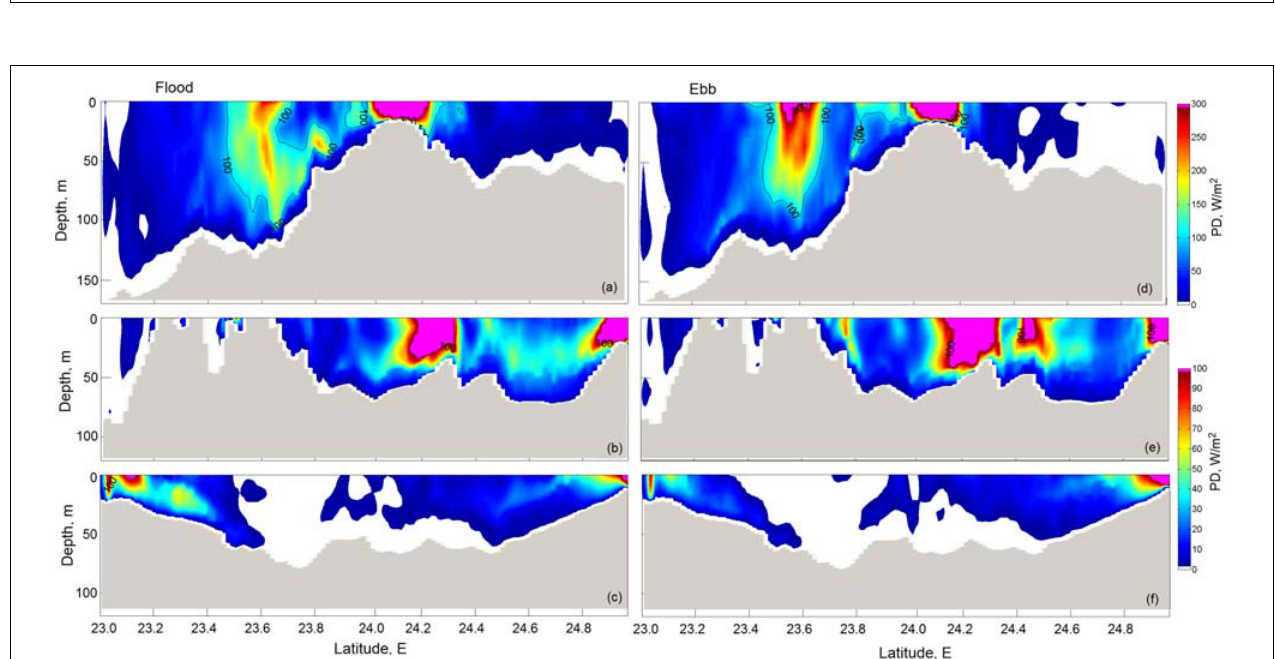
FIGURE 11 | The 20-min averaged power density along the meridional sections for peak flood (left panel) and ebb (right panel) velocities along (a,d) MS1, (b,e) MS2, and (c,f) MS3, respectively.